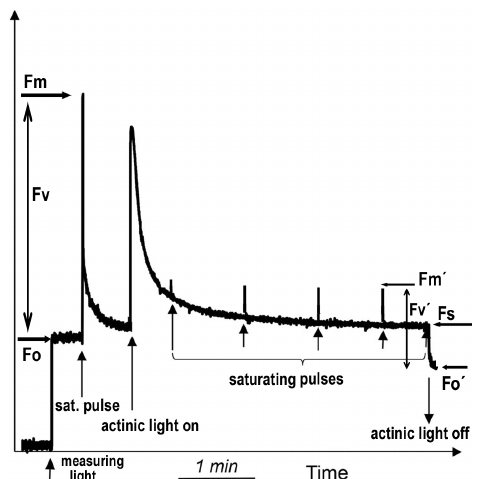
Figure 10. A typical modulated fluorescence trace using dark-adapted leaf material showing how F o , F m , F o ’, F m ’ and F s are formed to measure photochemical and non-photochemical parameters. In the dark-adapted state, a “measuring light” is switched on that is of too low intensity to induce electron transport through PSII but high enough to elicit the minimal level of chlorophyll fluorescence, termed F o . A brief saturating pulse of light results in the formation of the maximum yield of fluorescence, F m . The di ff erence between F m and F o is the variable fluorescence, F v . The ratio F v / F m is indicator of the maximum quantum yield of PSII photochemistry. The application of saturating pulses under actinic light illumination closes all the reaction centers and provides the maximum fluorescence in the light-adapted state, termed F m ’. The steady-state level of fluorescence in the light is termed F s and is measured immediately before switching o ff the actinic light. F o ’ is measured immediately after switching o ff the actinic light. The di ff erence between F m ’ and F o ’ is the variable fluorescence, F v ’. The ratio F v ’ / F m ’ is an indicator of the e ffi ciency of excitation energy captured by open PSII reaction centers.